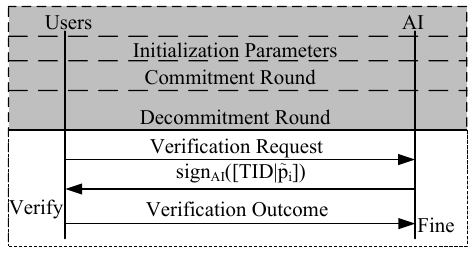
Figure 3. Our verifiable phase for homogeneous and heterogeneous